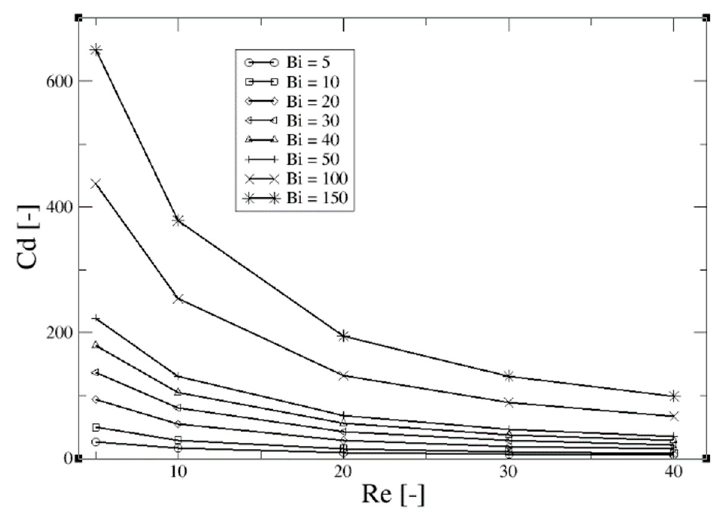
Figure 4. Variation of the drag coefficient for a single cylinder where the Reynolds number ( Re ) and Bingham number ( Bi ) are varied.